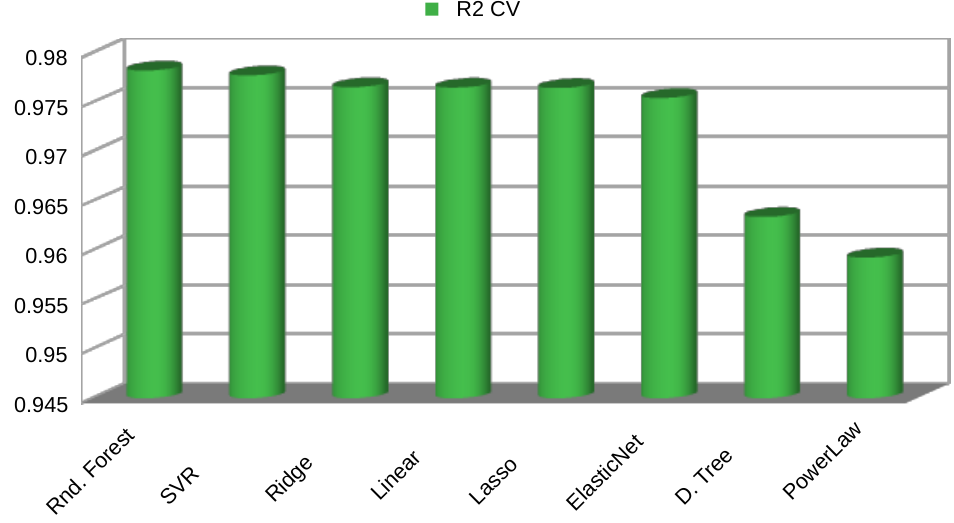
Figure 11. Performance